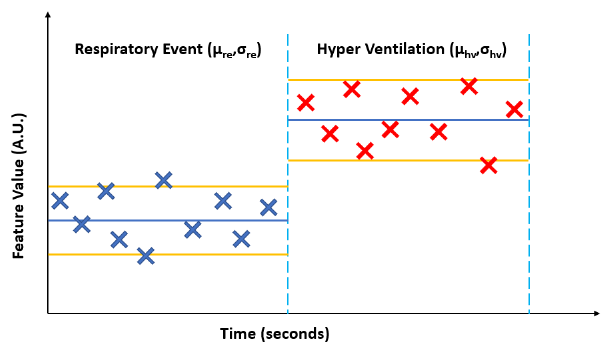
Figure 9. A generalized illustration of calculating the mean (μ) and standard deviation (σ) for an extracted feature from the envelope of the ultrasonic pulses for an apneic or hypopnea event (ARE or HRE, surmised as a respirator event RE) and the succeeding hyperventilation (HV).